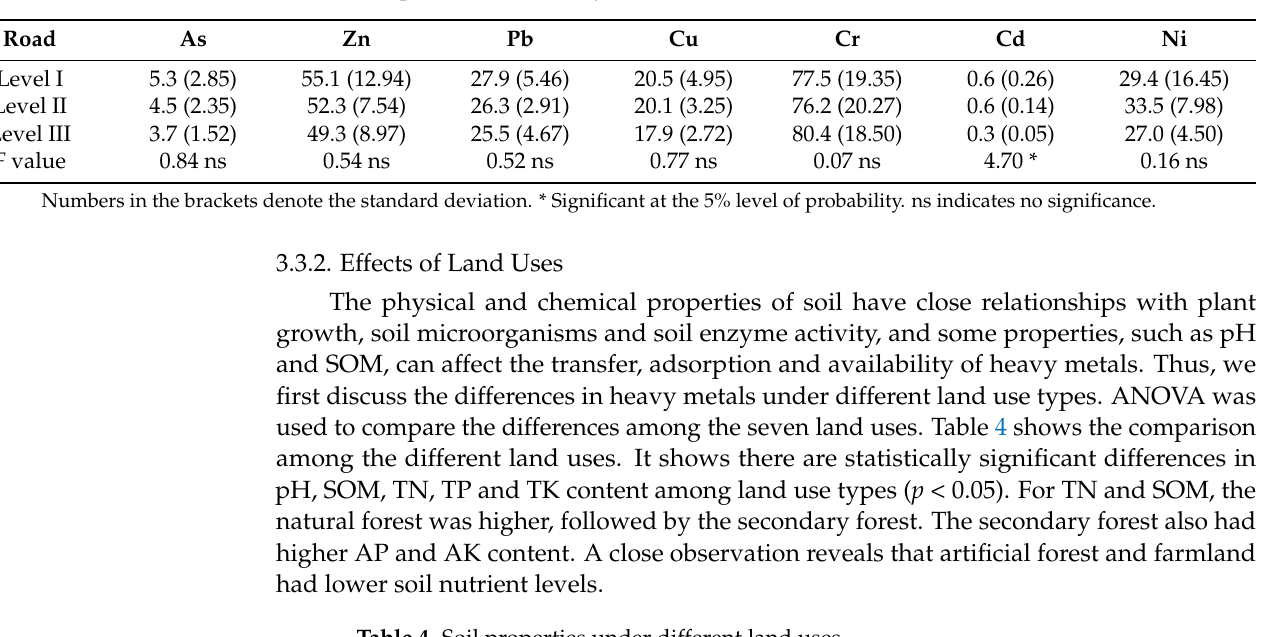
Table 3. Comparison of soil heavy metals near different road levels.